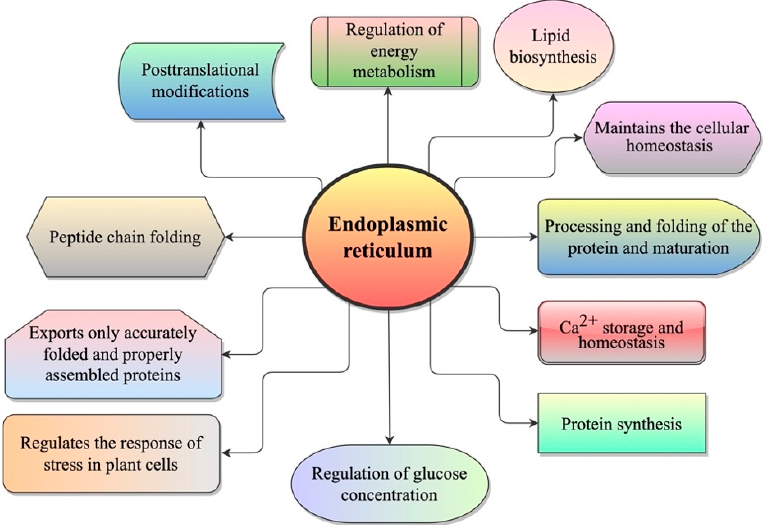
Figure 1. Different functions of the ER in plants.